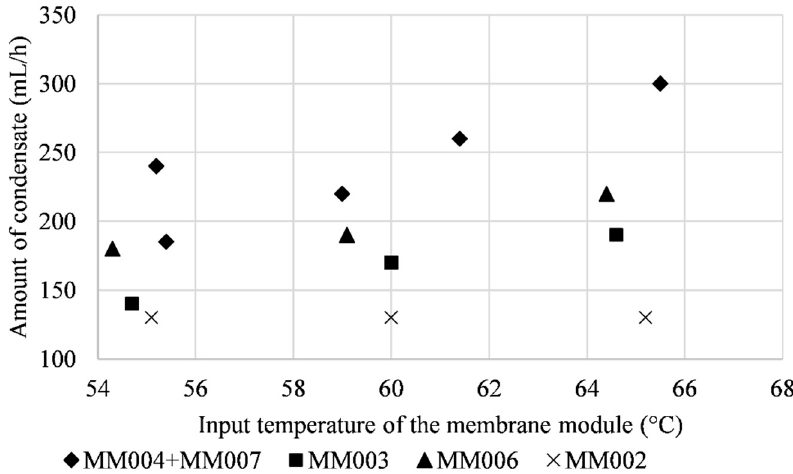
Figure 9. The dependence of the amount of condensate on the input temperature of the membrane module.